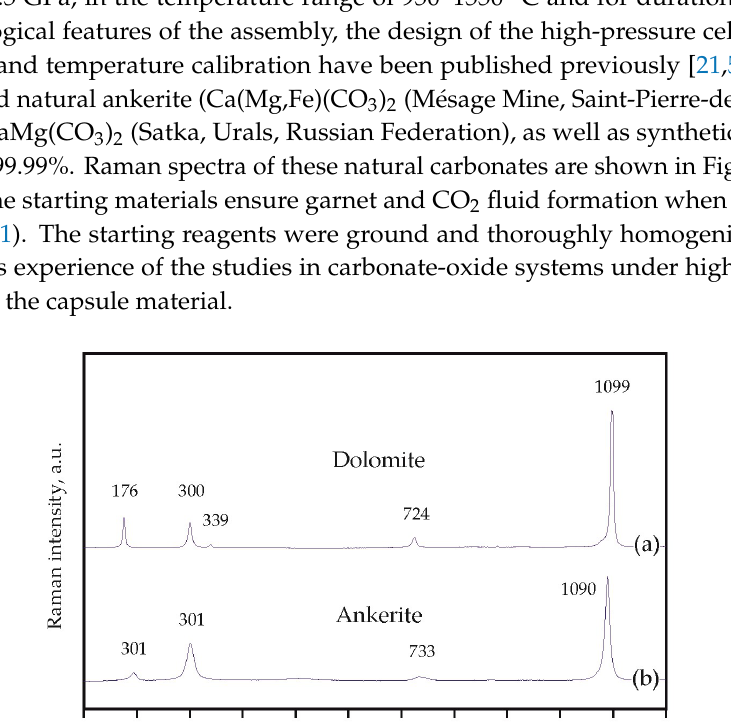
Figure 4. P,T diagram with previously experimentally constrained and calculated decarbonation